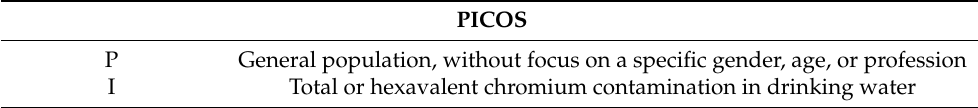
Table 1. Research question in the form